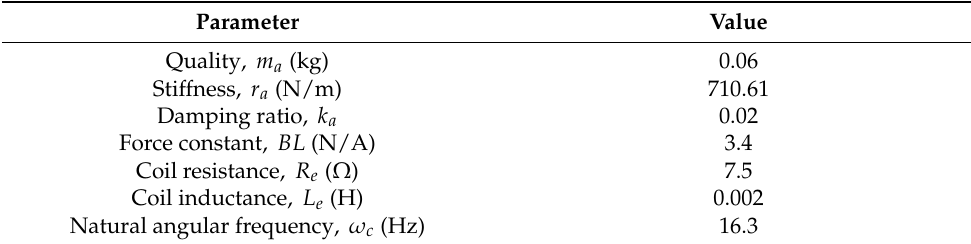
Table 1. Inertial actuator parameter.